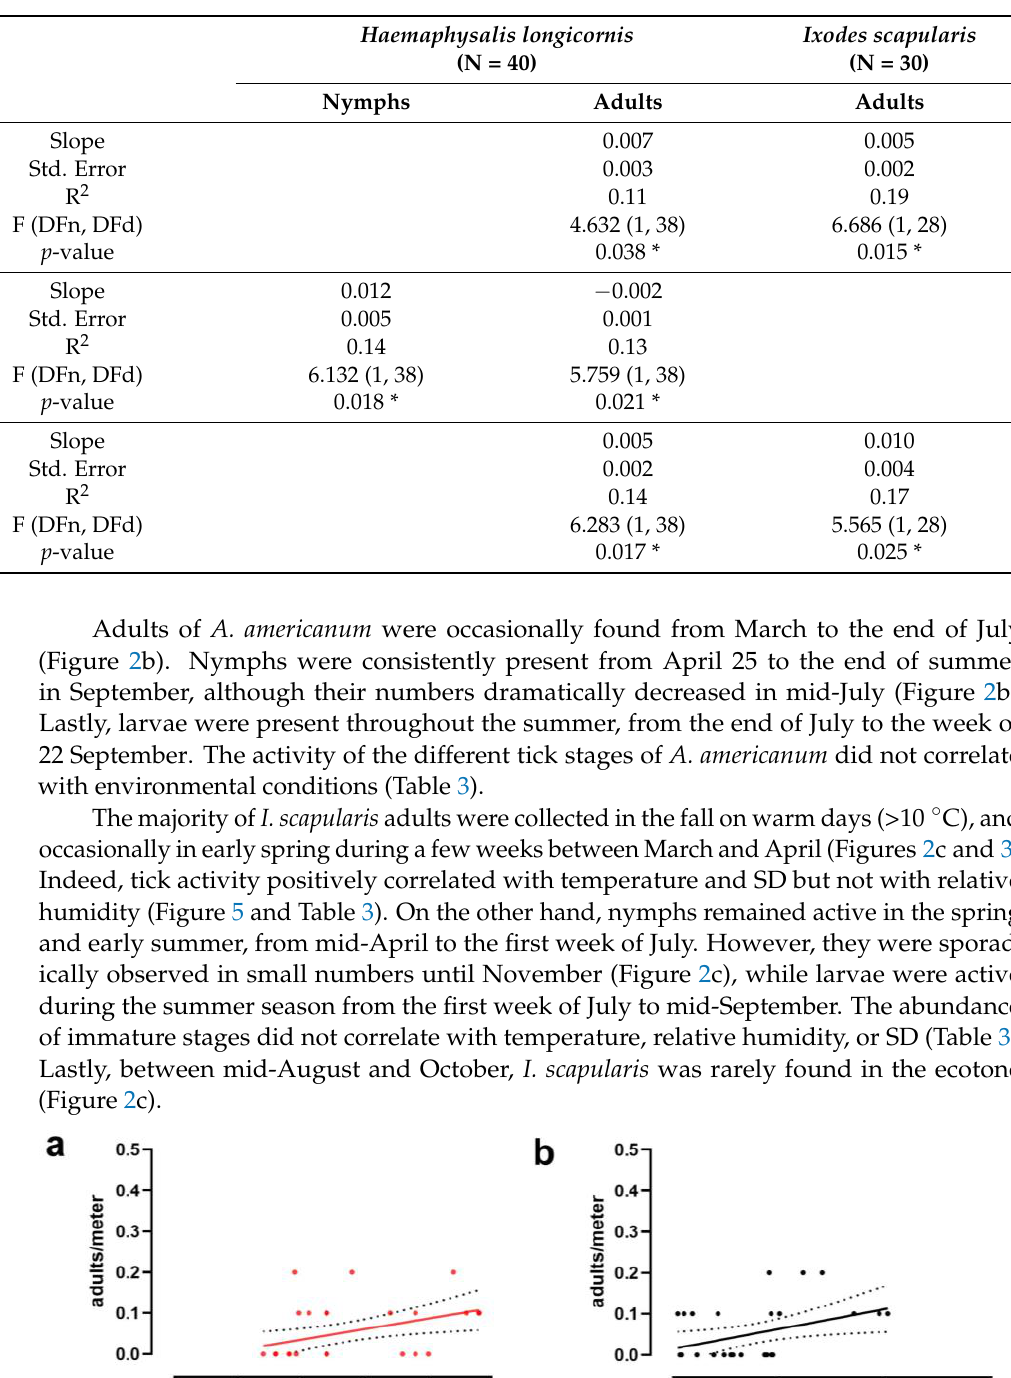
Table 4. Simple linear regressions between the relative abundance of tick activity peaks (Y) and